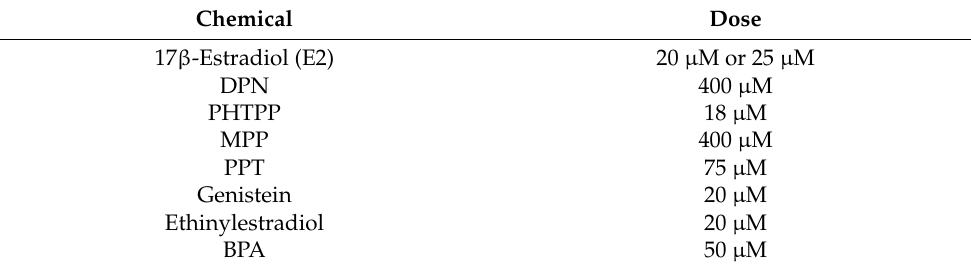
Table 2. Zebrafish embryo treatment dosages for chemical